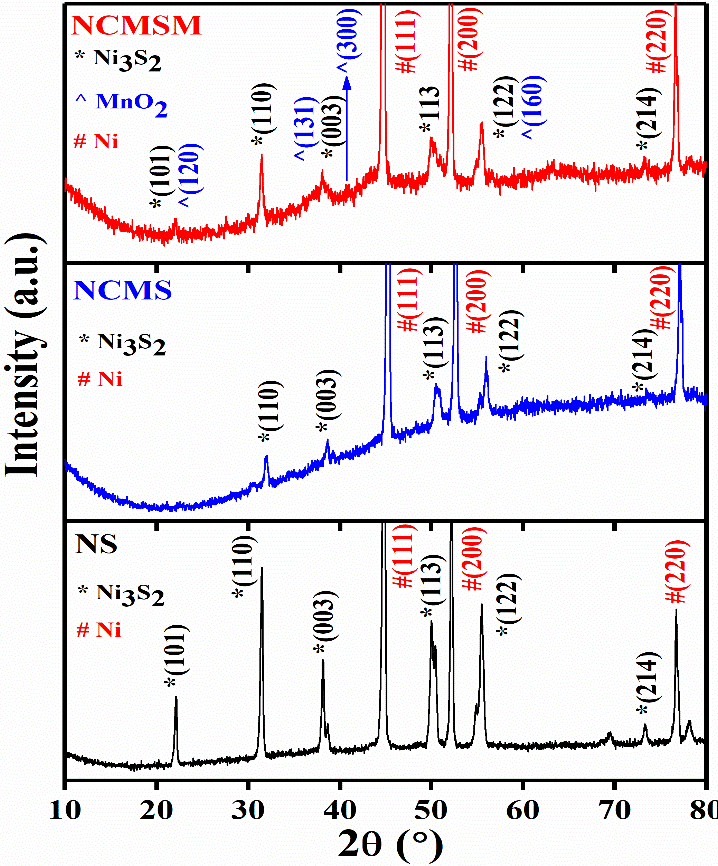
Figure 1. XRD patterns of NS, NCMS, and NCMSM samples.